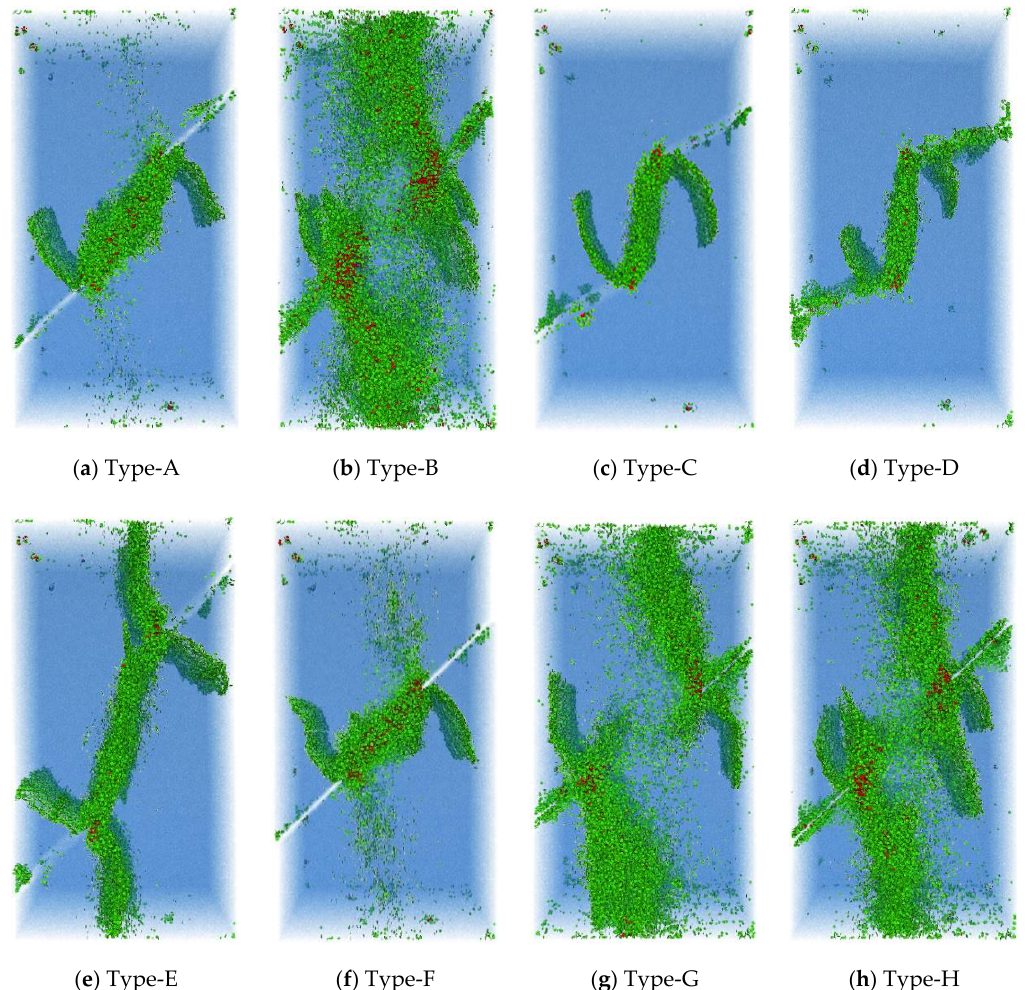
Figure 9. 3-D final failure patterns of the pre-fissured marble specimens in the confining pressure unloading simulations.